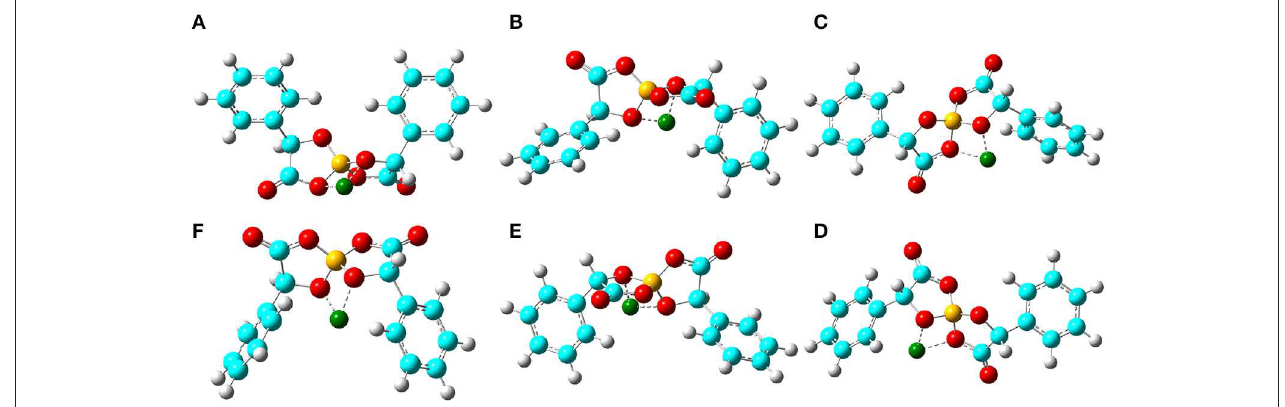
FIGURE 3 | Optimized ion-pair structures of an Li + ion in coordinating [BMB] anions with varied molecular chiralities determined from DFT calculations. The hydrogen, boron, carbon, and oxygen atoms in [BMB] anions are represented by white, yellow, cyan, and red spheres, respectively, and Li + ions are represented by green